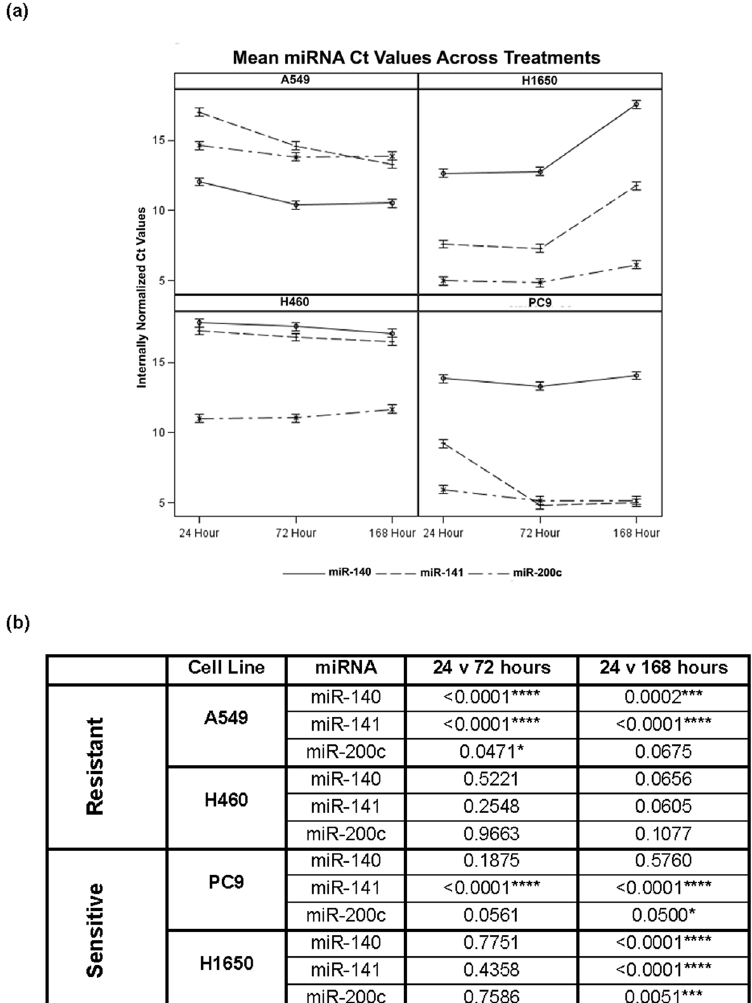
Figure 4. Time of TGF β treatment reflects changes in endogenous miRNA gene expression. Changes in endogenous gene expression were analysed using a five-way ANOVA considering the variables: TGF β treatment, SB-431542 treatment, time point, expression as internally normalized Ct values, and cell line, along with all interaction terms. ( a ) Data presented here is aggregated by averaging over treatments in order to capture overarching trends in miRNA and cell line patterns at multiple time points. Fine-scale trends were broken down by individual treatments as presented in Supplemental Figure 4. ( b ) Comparison of the significance of endogenous expression changes between time points samples and by individual miRNA genes in each cell